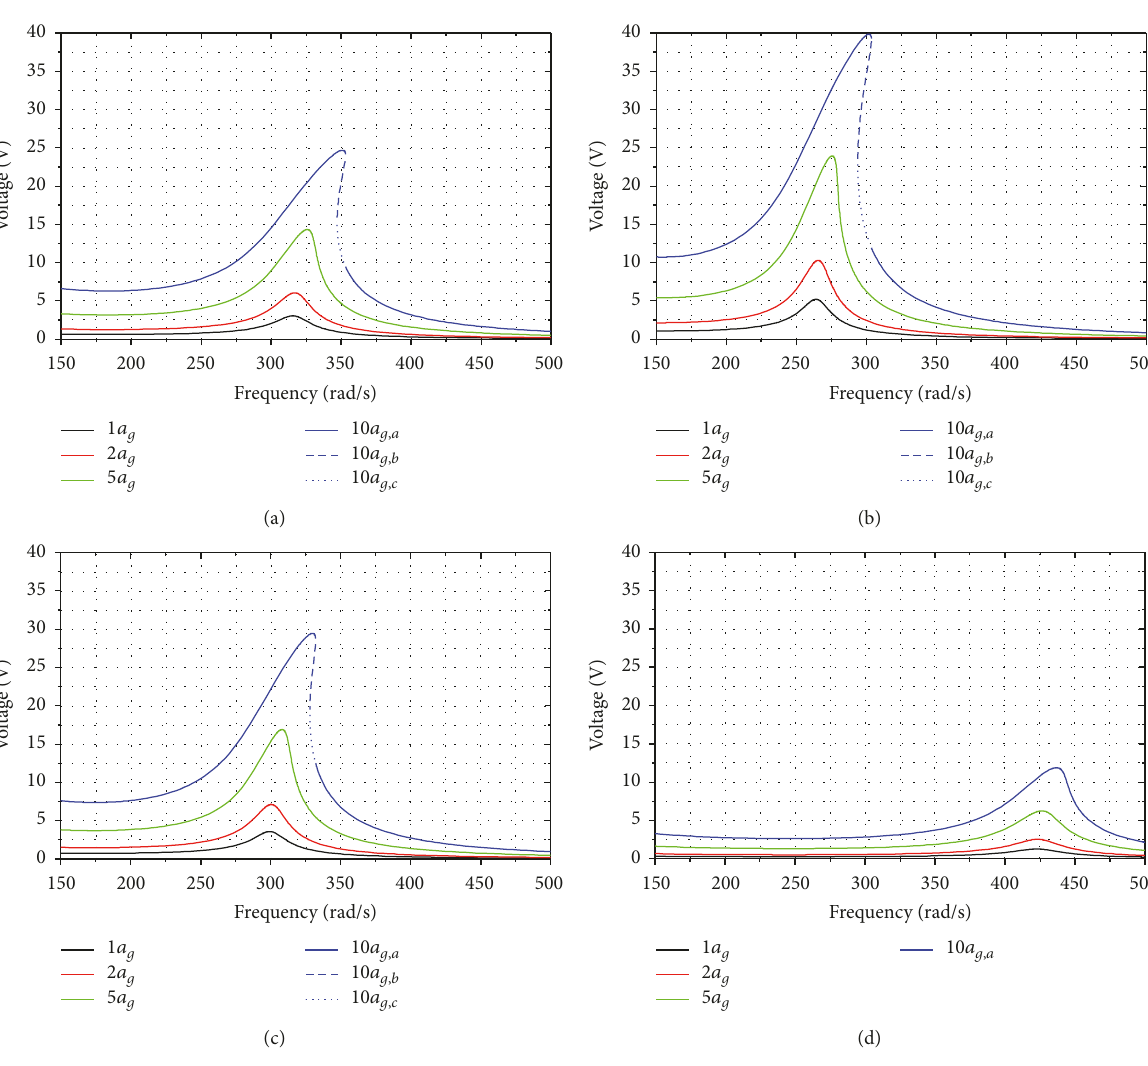
Figure 16: FRFs of the maximum voltage for base acceleration amplitudes ranging from 1 𝑎 𝑔 to 10 𝑎 𝑔 , where (a) 𝑇 mylar = 𝑇 0 mylar , (b) 𝑇 mylar = 0.8𝑇 0 𝑇 = 0.9𝑇 0 𝑇 = 1.2𝑇 0 mylar mylar mylar , (c) mylar , and (d) mylar .